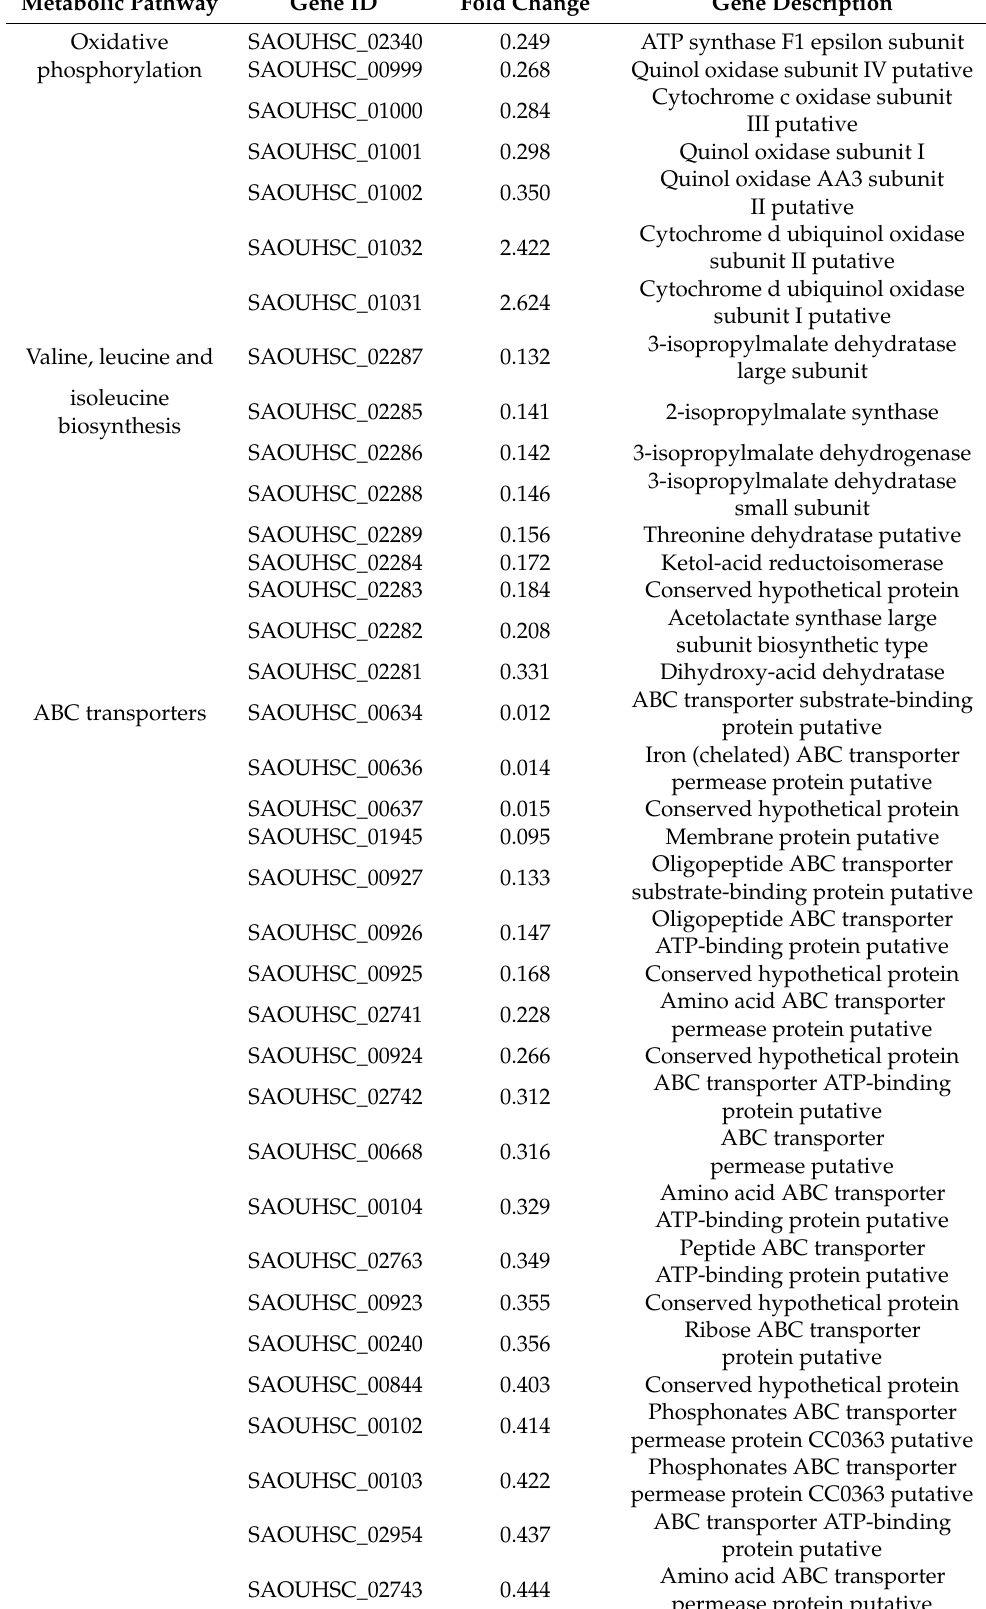
Table 5. The major altered metabolic pathways in S. aureus ATCC25923 mediated by Fragment 1 from C. communis